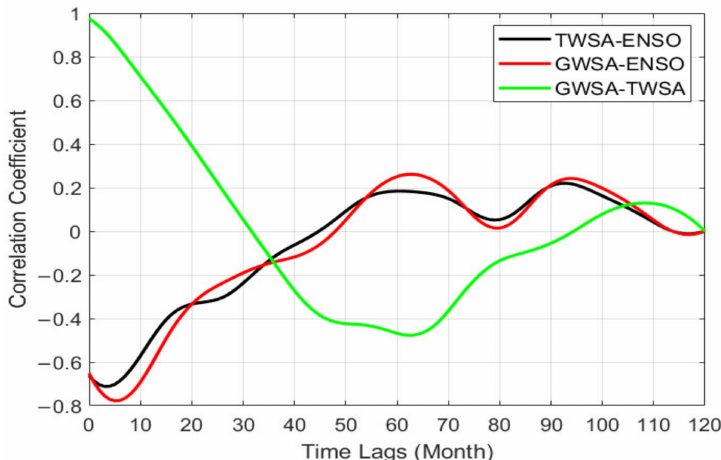
Figure 12. Correlations among the interannual changes of ENSO, TWSA VRB and GWSA VFL from 2007 to 2016. The interannual time series were obtained by removing the linear trend from the long-term time series. The linear trends were estimated using the least square fitting approach while the long-term time series were derived by applying the seasonal and trend decomposition using loess (STL)